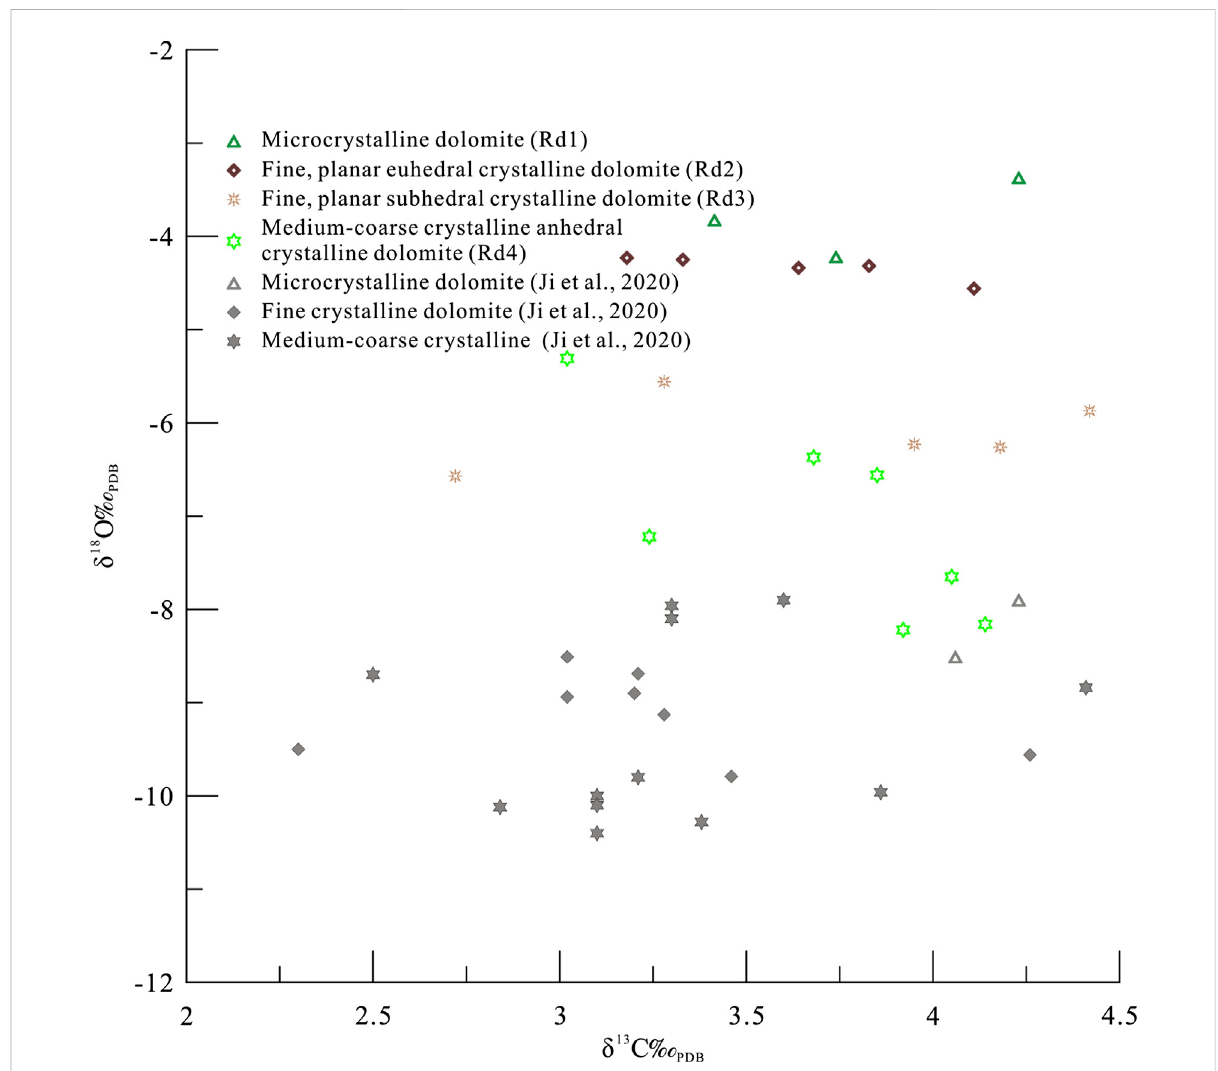
FIGURE 11 Comparisons of cross-plots showing δ 18 O vs. δ 13 C for different types of dolomite without misty centers and clear rims with previous research